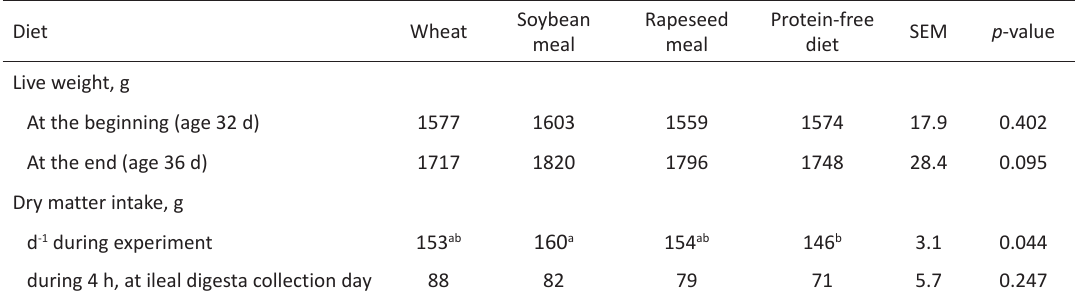
Table 3. Live weight at the beginning (age 32 d) and at the end (age 36 d) of the experiment and average feed intake of broilers during the experiment and at the slaughter day (n=4 per treatment). Diet Wheat